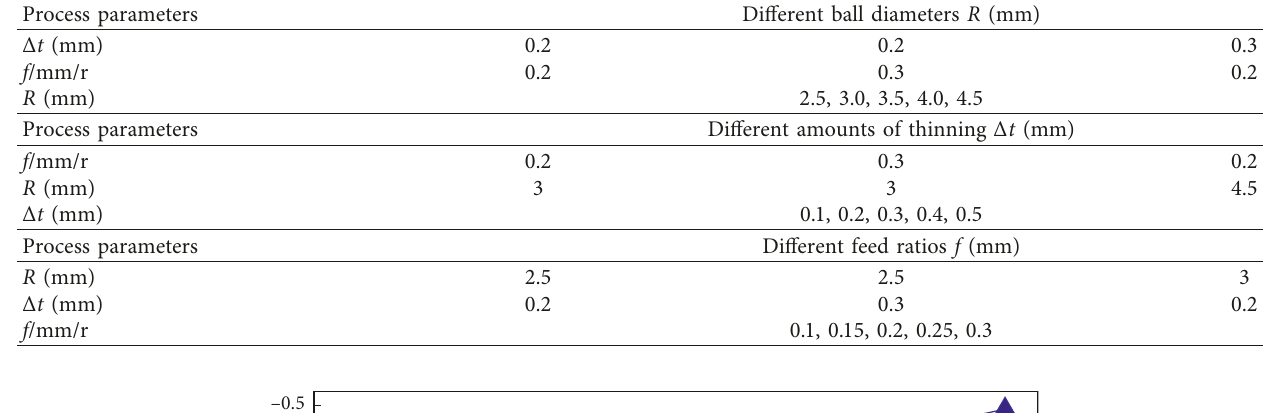
Table 3: Process parameters.